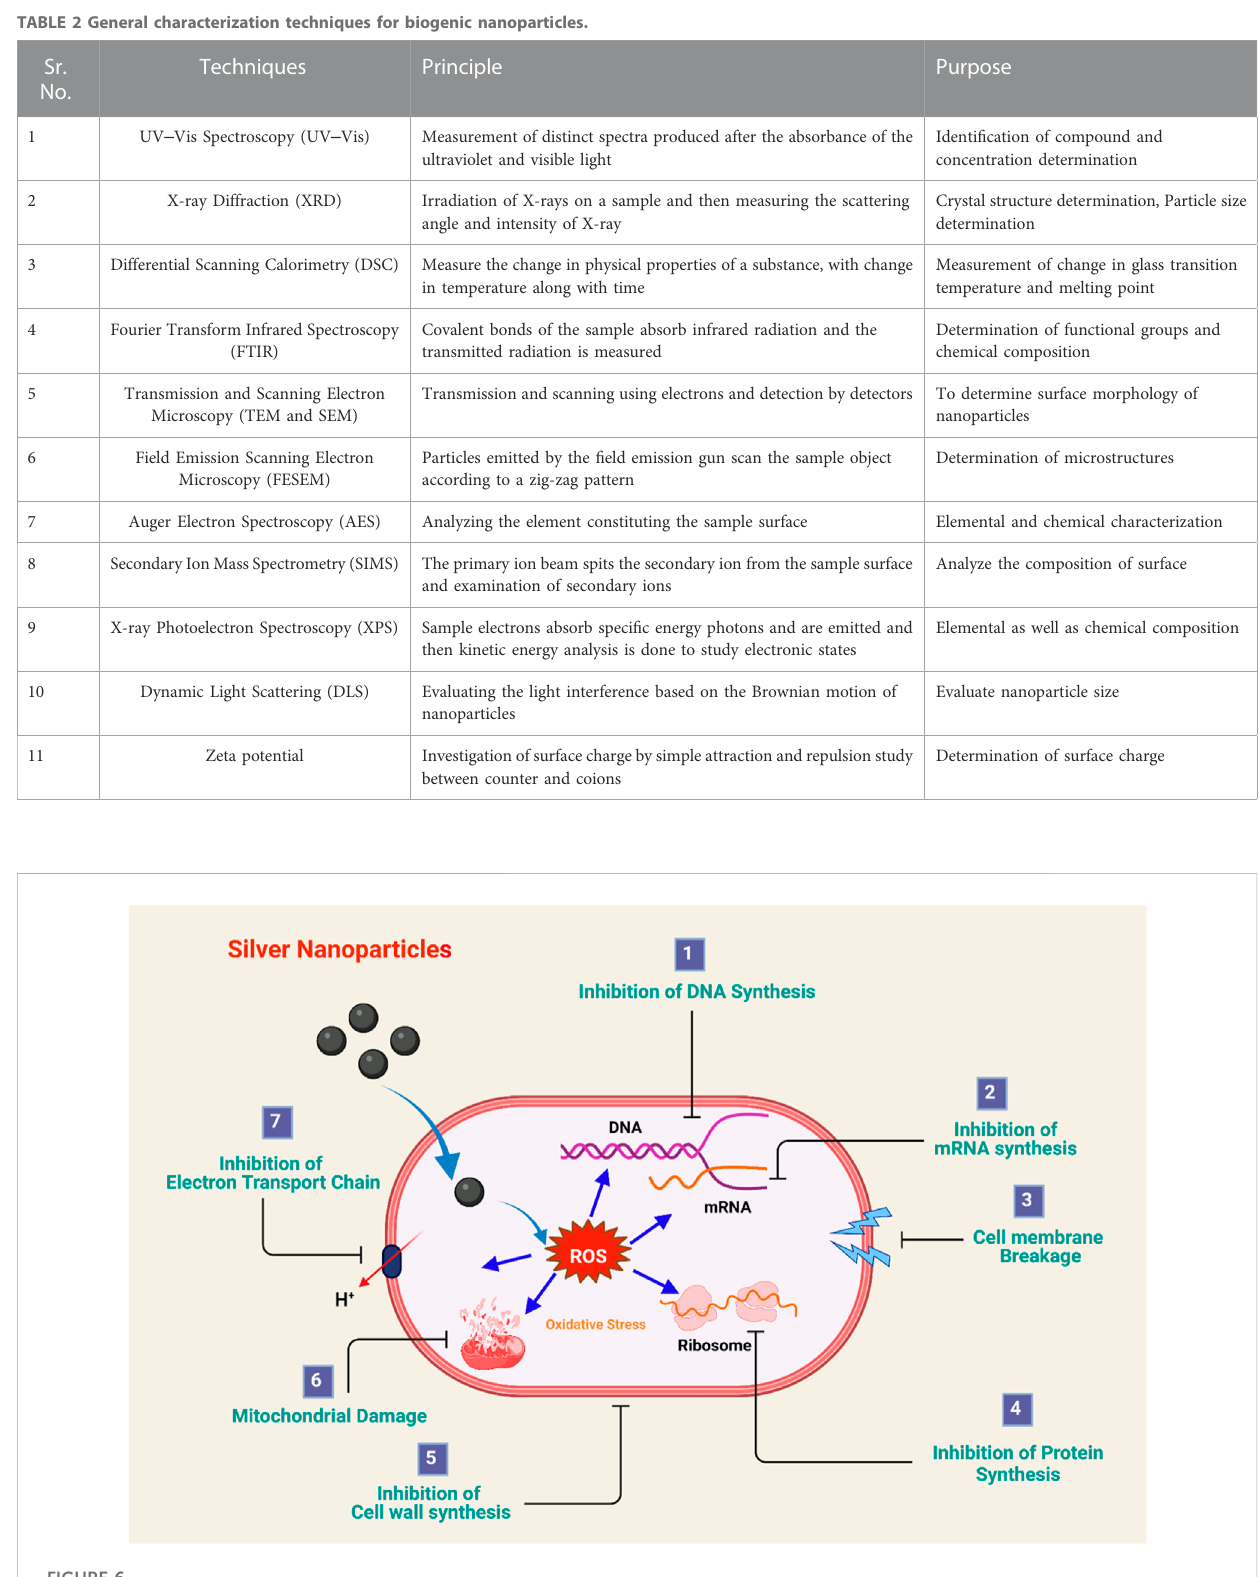
Frontiers in Bioengineering and